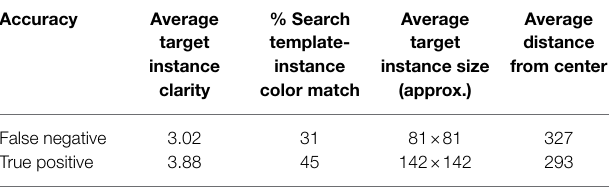
TABLE 6 | Average target instance features by accuracy, Experiment